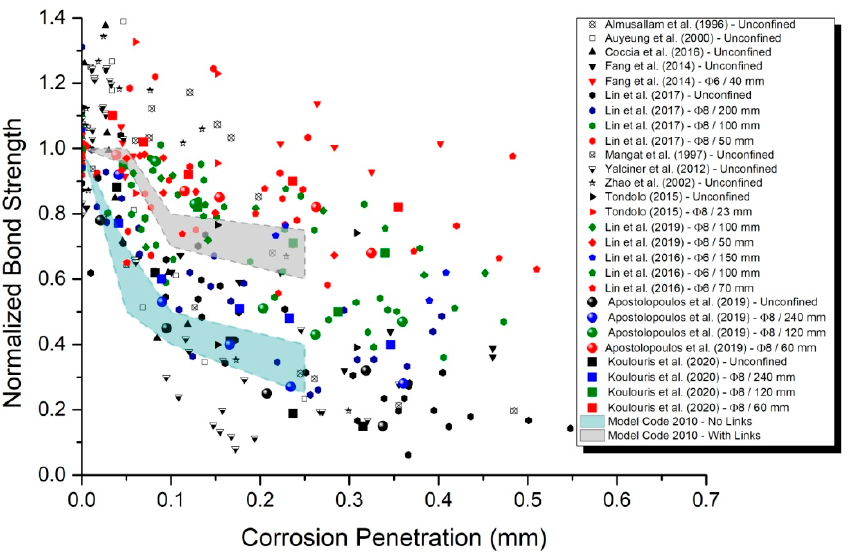
Figure 7. Normalized bond strength due to corrosion as a function of corrosion penetration depth of the tensile reinforcing bar, data from [16,17,21,23,26,36,37,39,41–46].